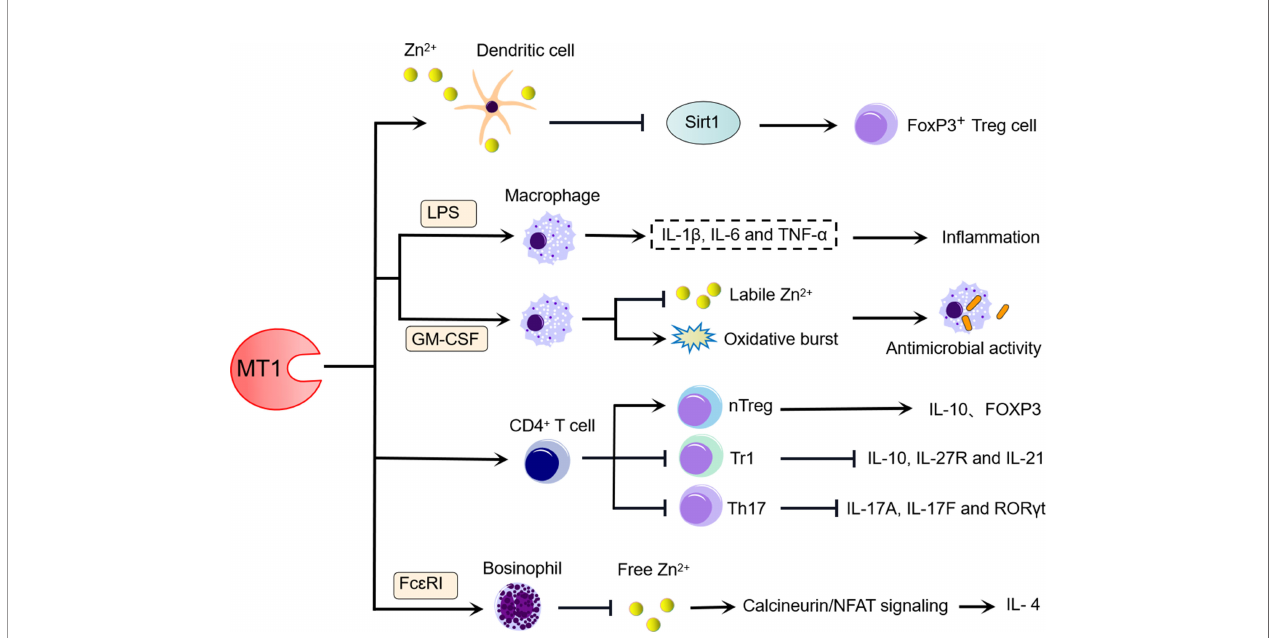
FIGURE 1 | MT1 in fl uences the differentiation and function of immune cells. (1) MT1 expressed on the cell membrane of IL-10-expressing DCs may dampen Sirt1- induced FoxP3 degradation and contribute to FoxP3 + T cell proliferation, and MT1 upregulation during this biological process is strongly dependent on ZnCl 2 signaling. (2) High levels of MT1 in LPS-induced macrophages can facilitate in fl ammation, whereas the increased level of MT1 in GM-CSF-induced macrophage bene fi ts the antimicrobial activity by inhibiting labile Zn 2+ and increasing oxidative burst. (3) MT1 positively regulates the differentiation of CD4 + T cells towards Tregs and negatively modulates the differentiation of CD4 + T cells towards Tr1 and Th17. (4) MT1 promotes the production of IL-4 derived from Fc e RI-induced basophils by limiting free Zn 2+ , which activates CaN/NFAT